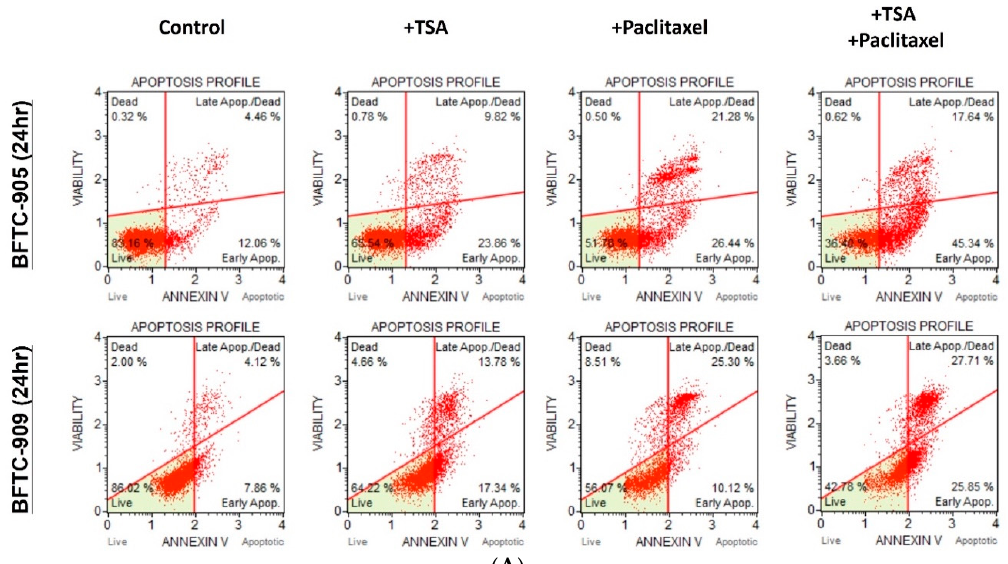
Figure 1. MTT cell viability assay of BFTC-905 and BFTC-909 with trichostatin A (TSA), paclitaxel, or combination treatment. Cells were treated with the relevant drug for 24 h, and cell viability was analyzed at OD540 with untreated cells defined as 100% ( n = 6). Cell viability is presented as mean ± SD. ( A ) The 50% inhibitory concentration (IC 50 ) of TSA treatment at 24 and 48 h was >1 μ M and = 27 nM, respectively, for BFTC-905 and >1 μ M and = 88 nM, respectively, for BFTC-909. By contrast, the IC 50 of paclitaxel treatment were approximately 1 μ M and 7.5 nM, respectively, for BFTC-905 and approximately 0.05 μ M and 1.7 nM, respectively, for BFTC-909 at 24 and 48 h. ( B ) Cotreatment with paclitaxel and TSA resulted in a significant difference in cell viability compared with paclitaxel alone (one-way ANOVA). * p < 0.05.